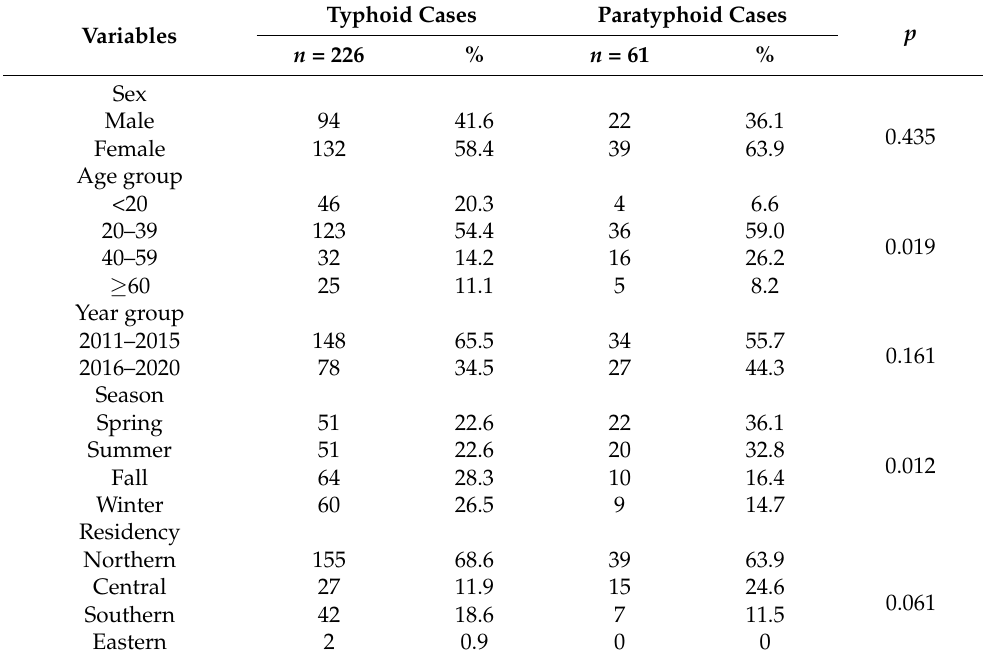
Table 3. Epidemiological features of typhoid and paratyphoid cases in Taiwan during the